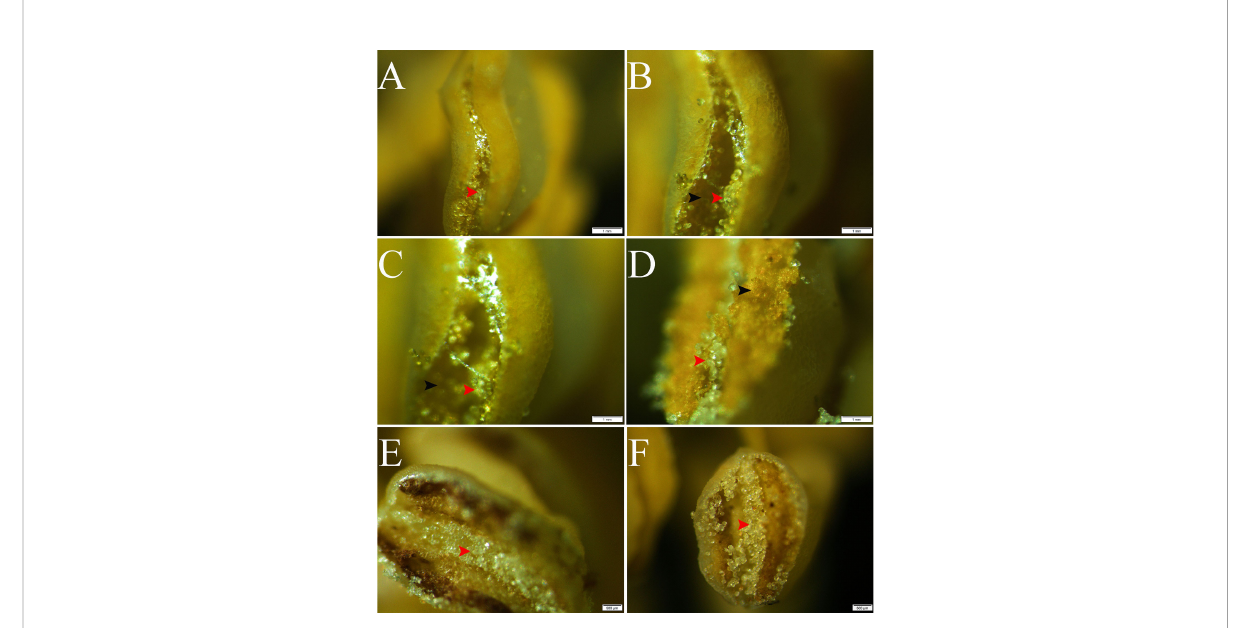
FIGURE 1 Release and distribution of normal and pseudopollen in Camellia oleifera normal anthers and abnormal anthers. (A – D) Normal anthers. (E, F) Anthers that do not normally produce fertile pollen. Bar = 1